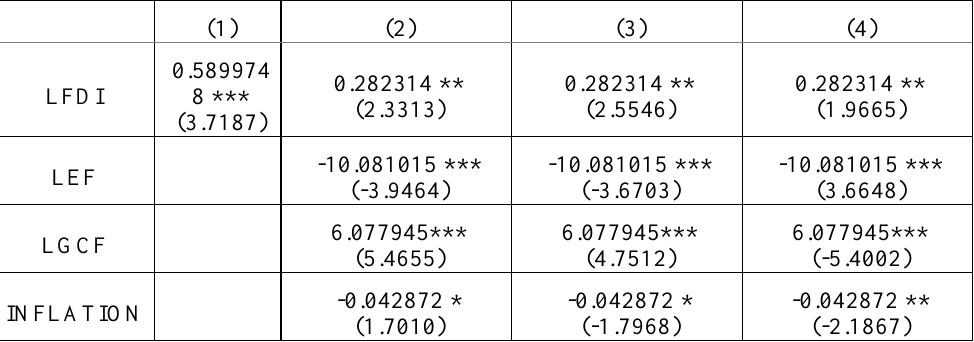
Table 4. relation between changes in per capita GDP (percent) and (log) net foreign direct investment